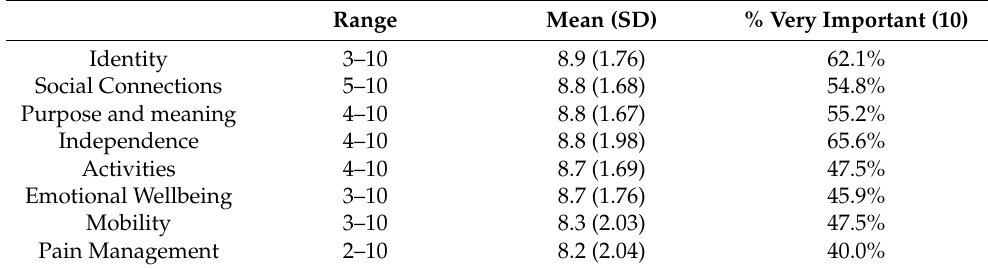
Table 4. Ranking of QoL